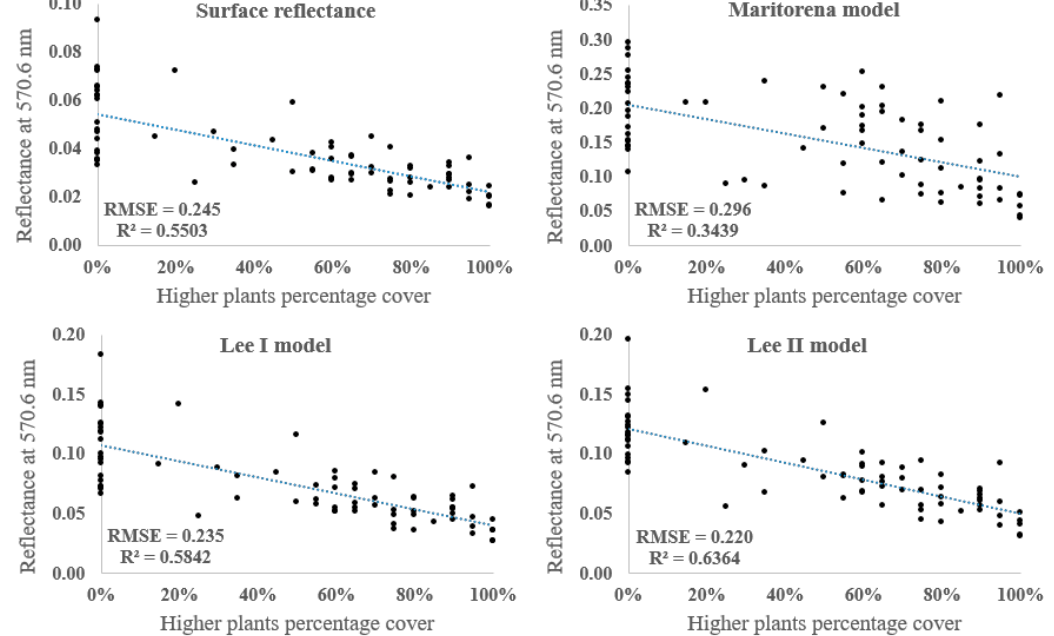
Figure 7. Relationships between the reflectance at the 570.6 nm and higher plants percent cover at the depth range of 0–3 m for the water surface reflectance and bottom reflectance produced by the Maritorena, Lee I and Lee II water column correction models.